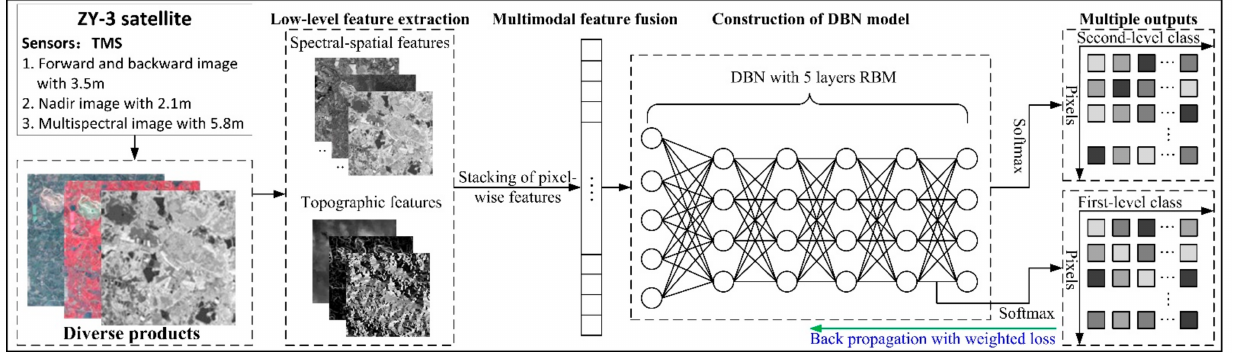
Figure 2. Summary of the multi-level output classification based on the deep belief network (DBN) model proposed in this